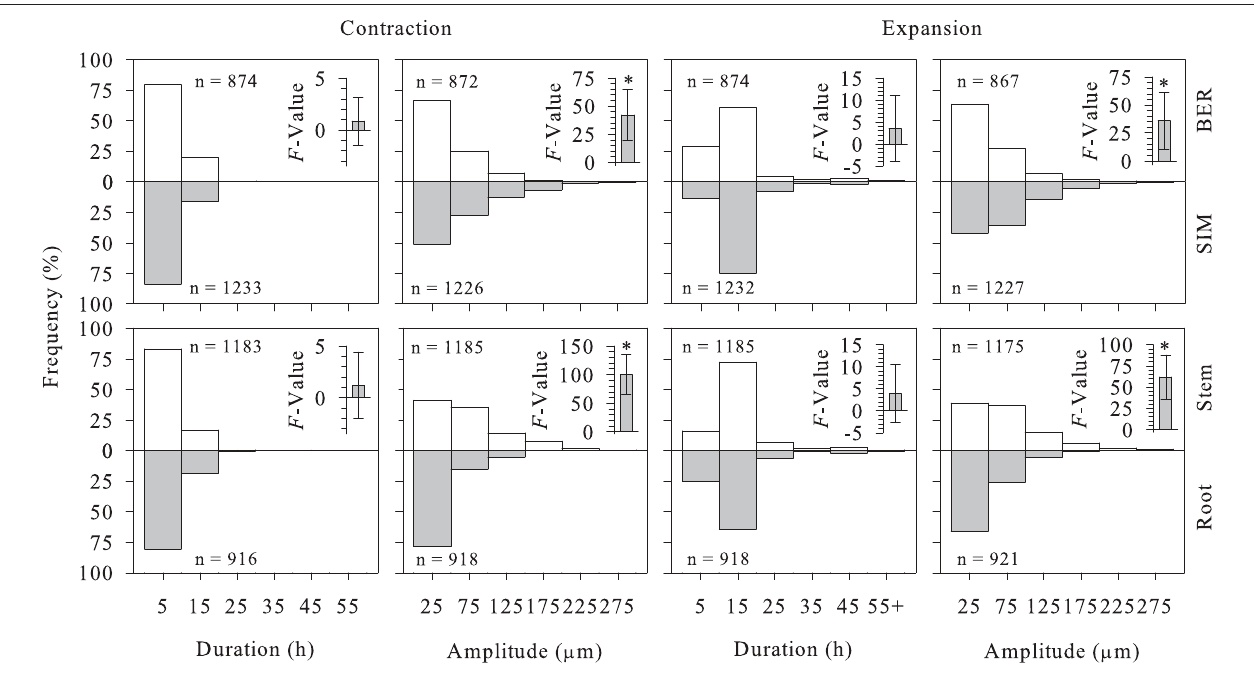
Figure 4 | Frequency distribution of duration and amplitude of contraction and expansion in stem and roots of black spruce in two stands of the boreal forest of Quebec, Canada. The enclosed vertical bars represent mean and twice standard deviation of the bootstrapped F -statistic calculated by 1000 replications. Asterisks indicate significant differences ( P < 0.05), while differences are considered non-significant ( P > 0.05) when the error bars